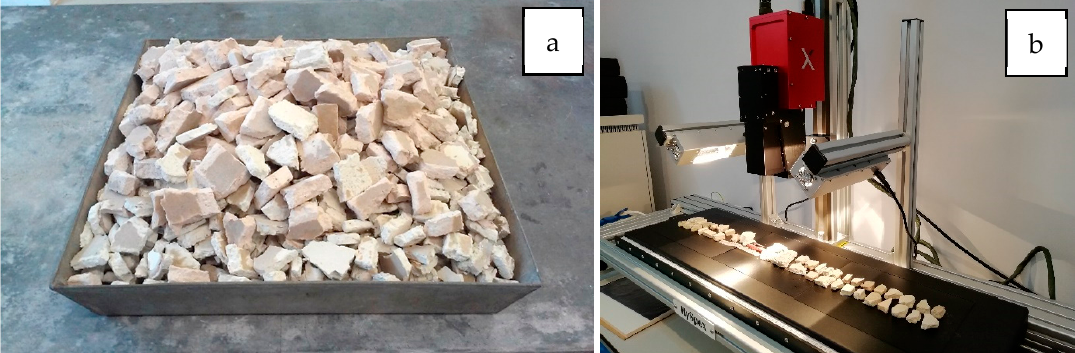
Figure 2. Refurbishment plasterboard waste fragments composed of gypsum core and lining paper ( a ) and laboratory-scale experimental setup with advanced HSI camera, air-cooled tubular halogen lamps and sliding scanning table for in-line material classification ( b ).